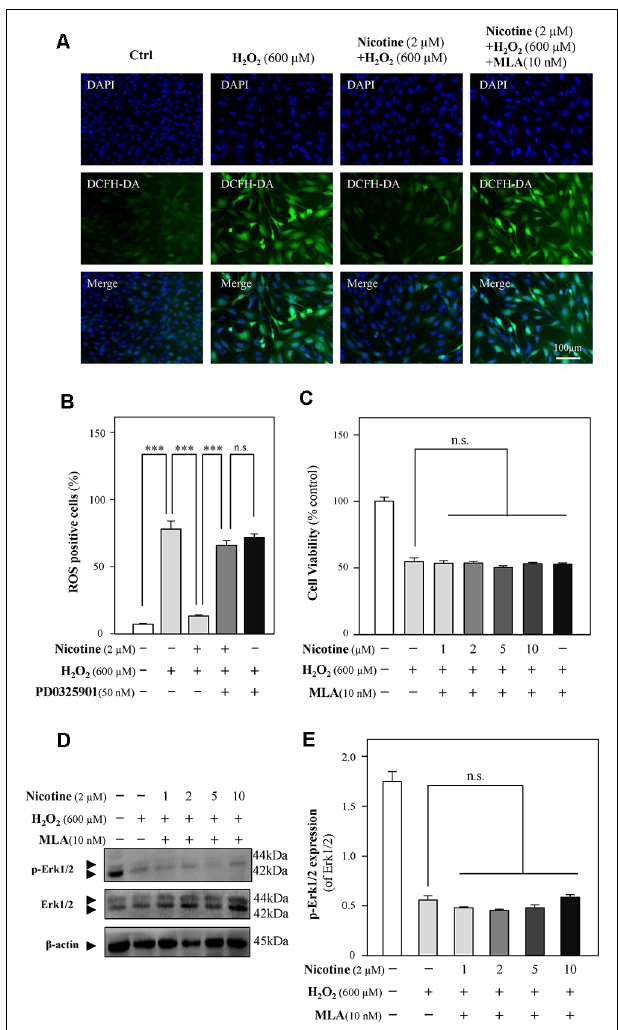
FIGURE 6 | The Erk1/2 signaling pathway is activated by the binding of nicotine to α 7-nAChRs. Cultured HT-22 cells were treated with or without nicotine (1, 2, 5, and 10 µ M) for 24 h, followed by the application of H 2 O 2 (600 µ M) in the presence or absence of MLA (an inhibitor of α 7-nAChRs, 10 nM) for another 24 h; the control group consists of the untreated cells. (A) Cells were stained with DCFH-DA. Cover glasses with cells were fixed and observed under a fluorescent microscope. Bar = 100 µ m. (B) Mean fluorescence density of ROS level was calibrated. (C) Cell viability test was performed using CCK-8 kit, and the changes were shown in histograms as percentage with control. (D) The protein expressions of p-Erk1/2 and Erk1/2 were determined by western blotting (upper panel). Expression of β -actin served as loading control. (E) The quantitation of p-Erk1/2 and Erk1/2 expressions was calibrated from panel (D) . All data in bar charts represent mean ± SEM, n = 3. n.s., no significance. ∗∗∗ p < 0.001 vs. control group. MLA, methyllycaconitine